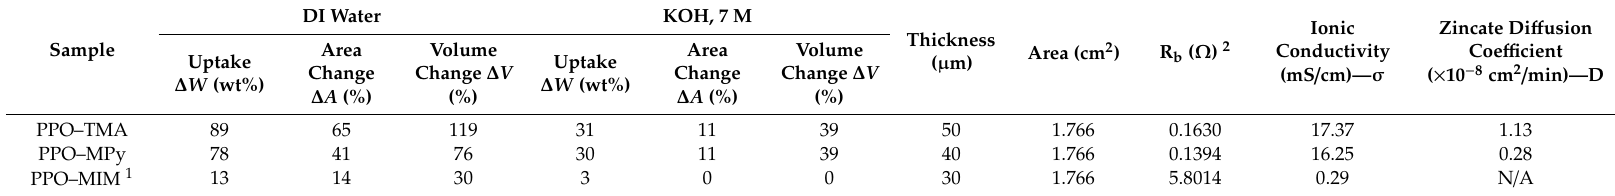
Table 1. Basic properties of PPO–TMA, PPO–MPy, and PPO–MIM separator